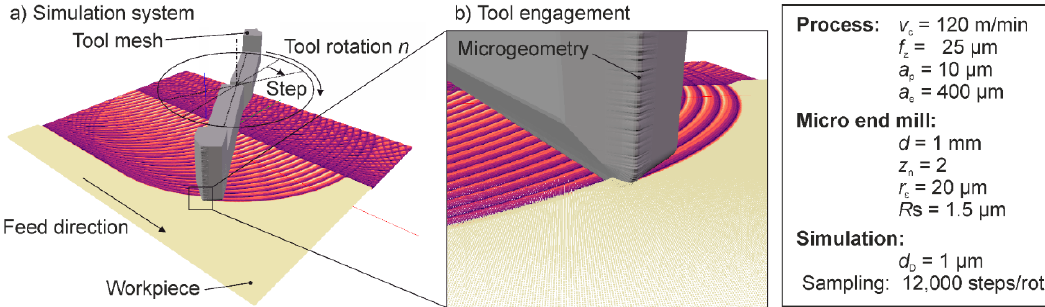
Figure 4. Illustration of the applied geometric physically-based simulation system showing two adjacent tool paths with the discretized workpiece surface model ( a ) Representation of a tool in engagement situations; ( b ) Triangular mesh representation and surface topography resulting from a certain process configuration.